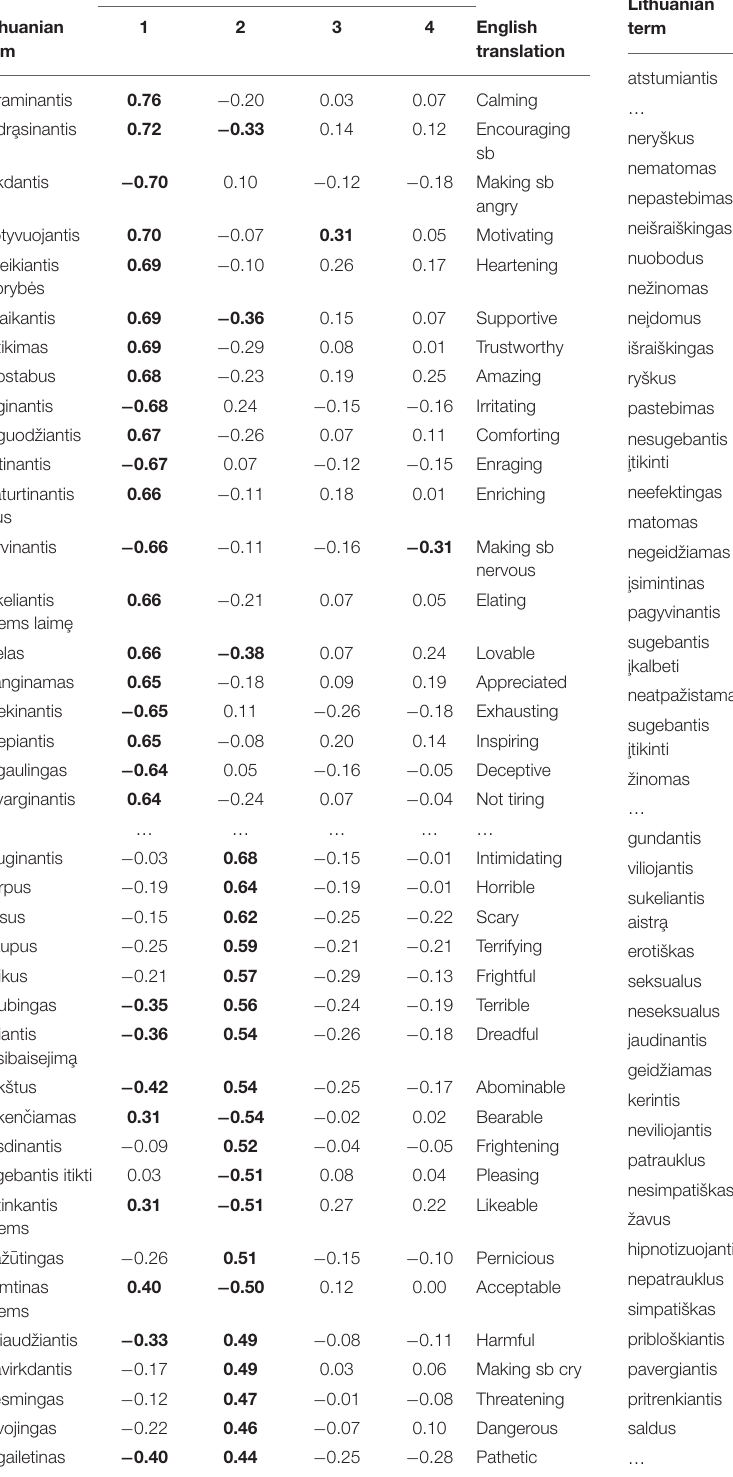
TABLE 3 | Varimax-rotated four-factor structure of the social effects in the observer-rating data (20 highest loading terms for each dimension). Principal components